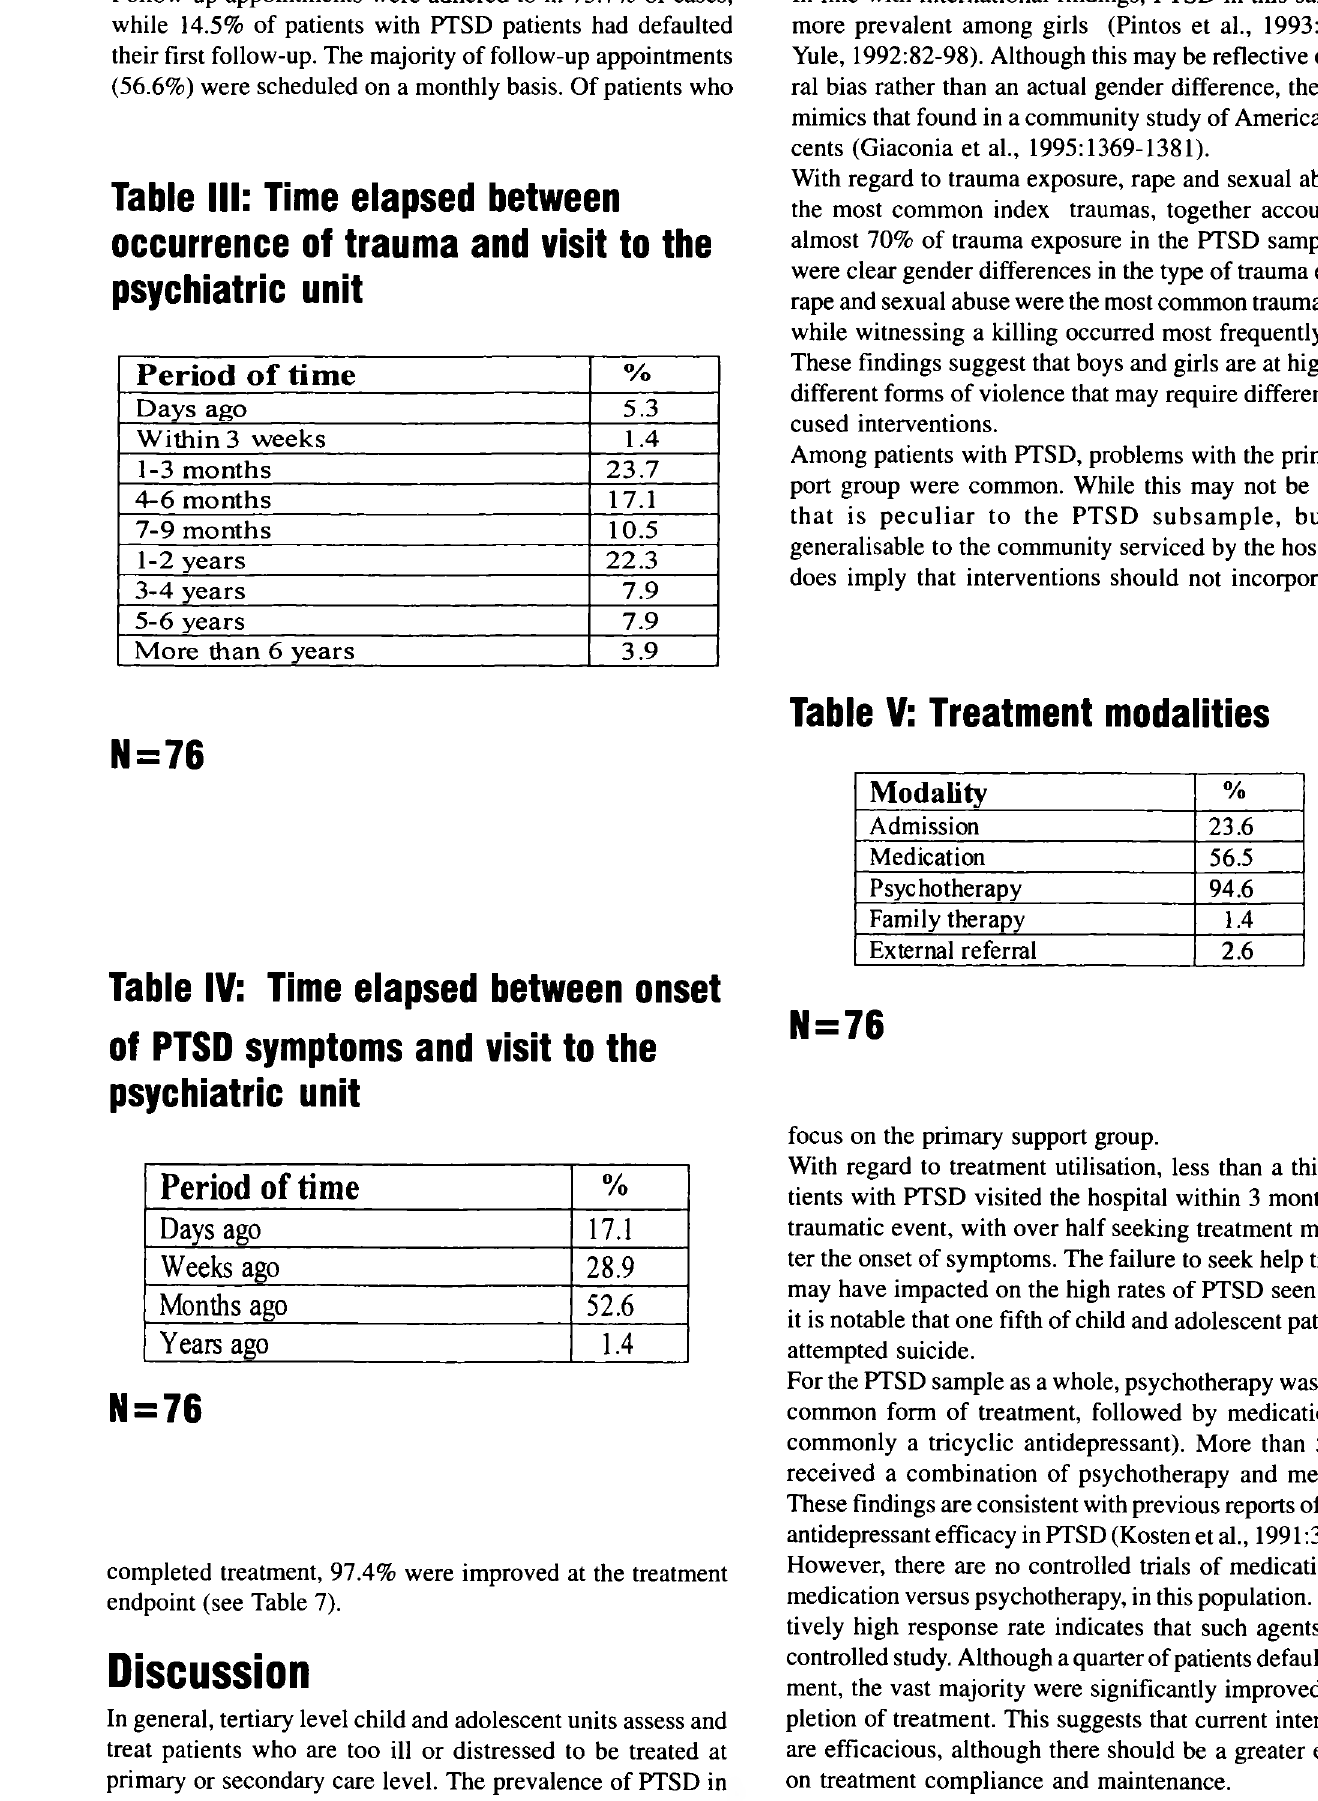
Table III: Time elapsed between occurrence of trauma and visit to the